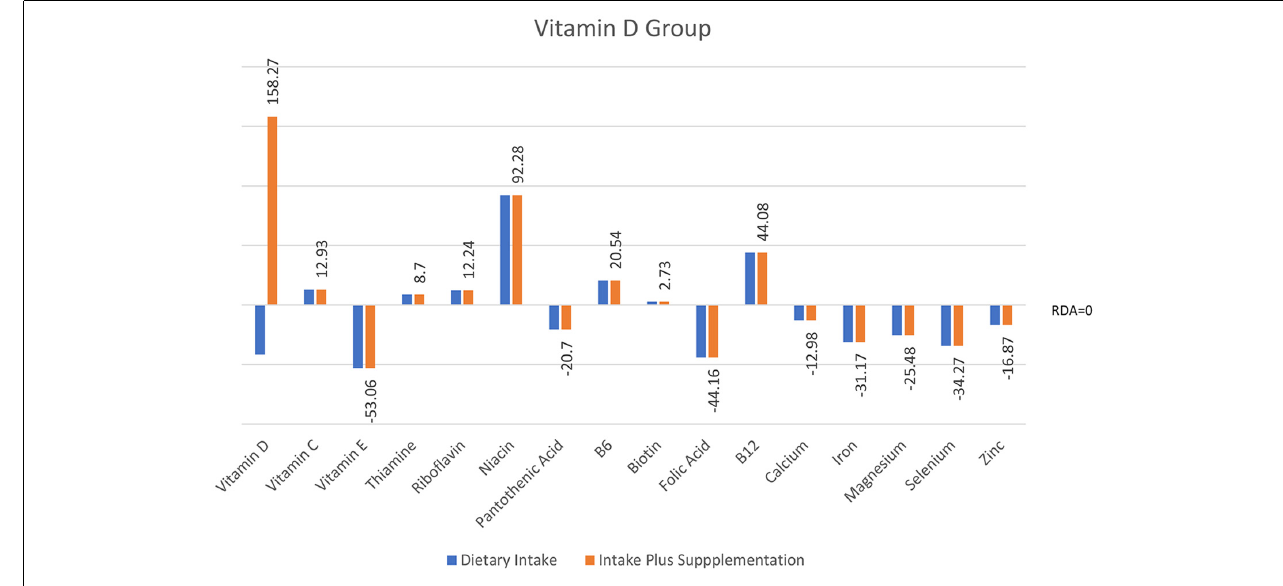
FIGURE 3 | Intake of micronutrients in the Vitamin D group pre- and post-intervention ( n = 20).